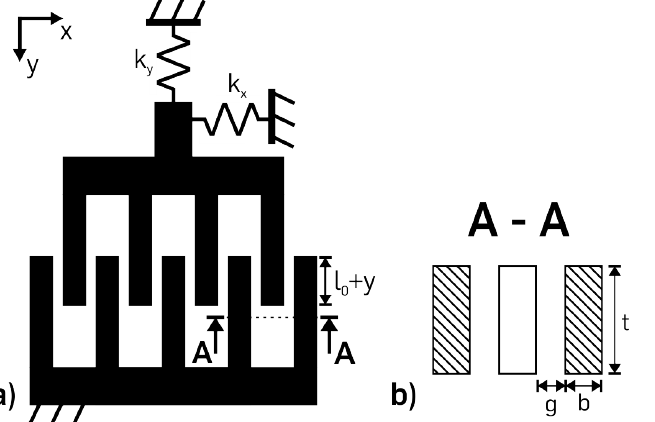
Figure 1. ( a ) Schematic view of a single-sided electrostatic comb drive actuator in y-direction with the finger overlap l 0 and the spring stiffness in x- and y-direction k x and k y . ( b ) A to A cross-section of the finger electrodes with finger gap g , width b and depth t